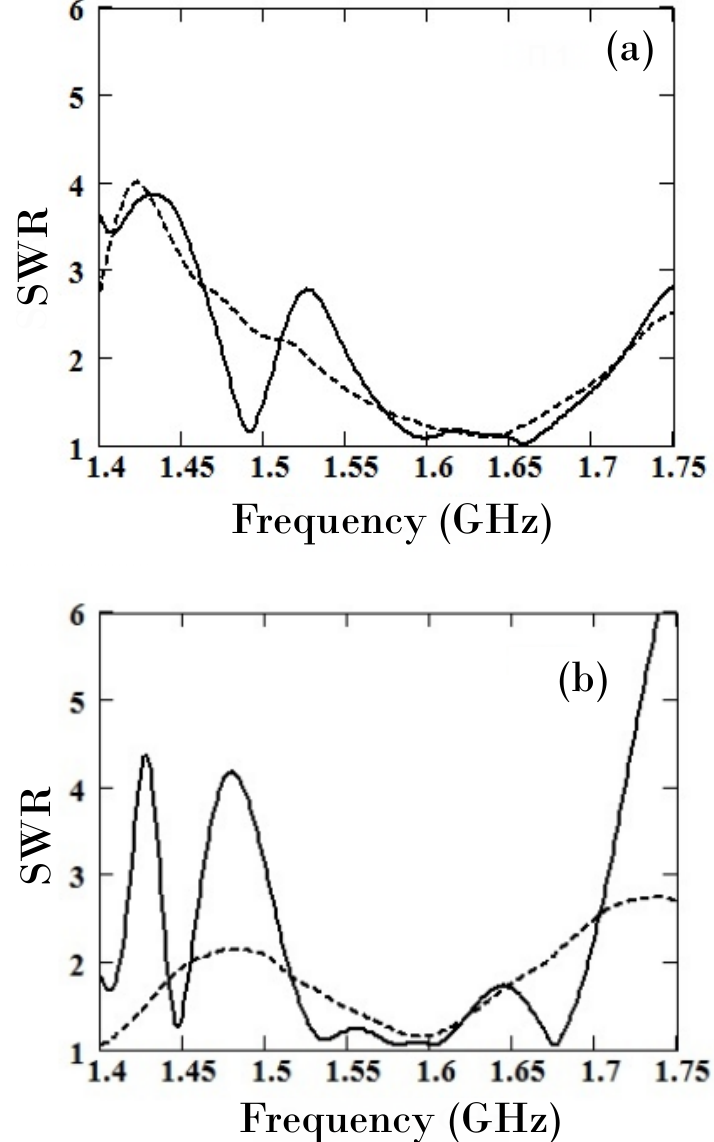
Figure 11. SWRs of L -range antennas made from metal (solid line) and fiber (dashed line), ( a ) without and ( b ) with a polarization